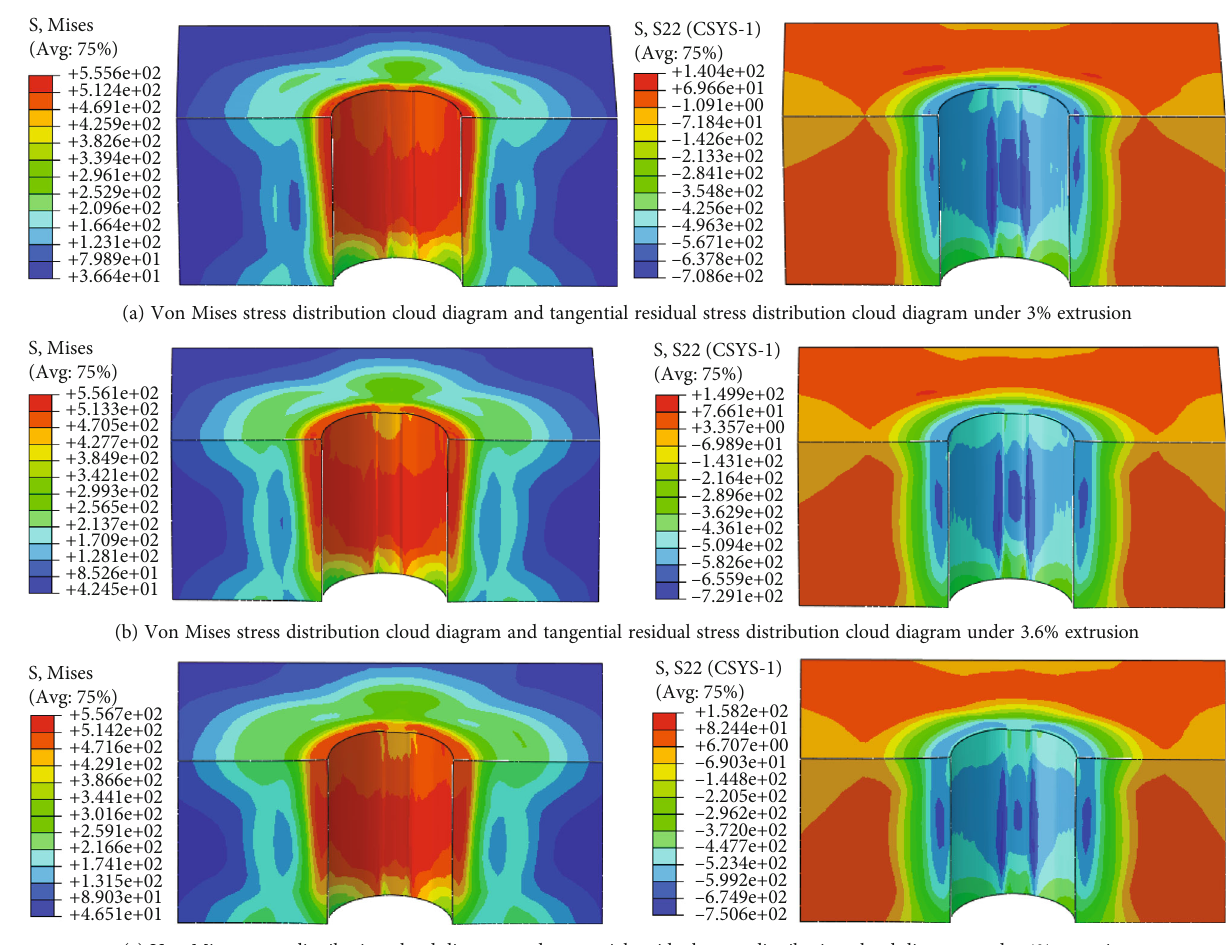
Figure 11: Von Mises stress cloud diagram and tangential residual stress cloud diagram under di ff erent squeezing